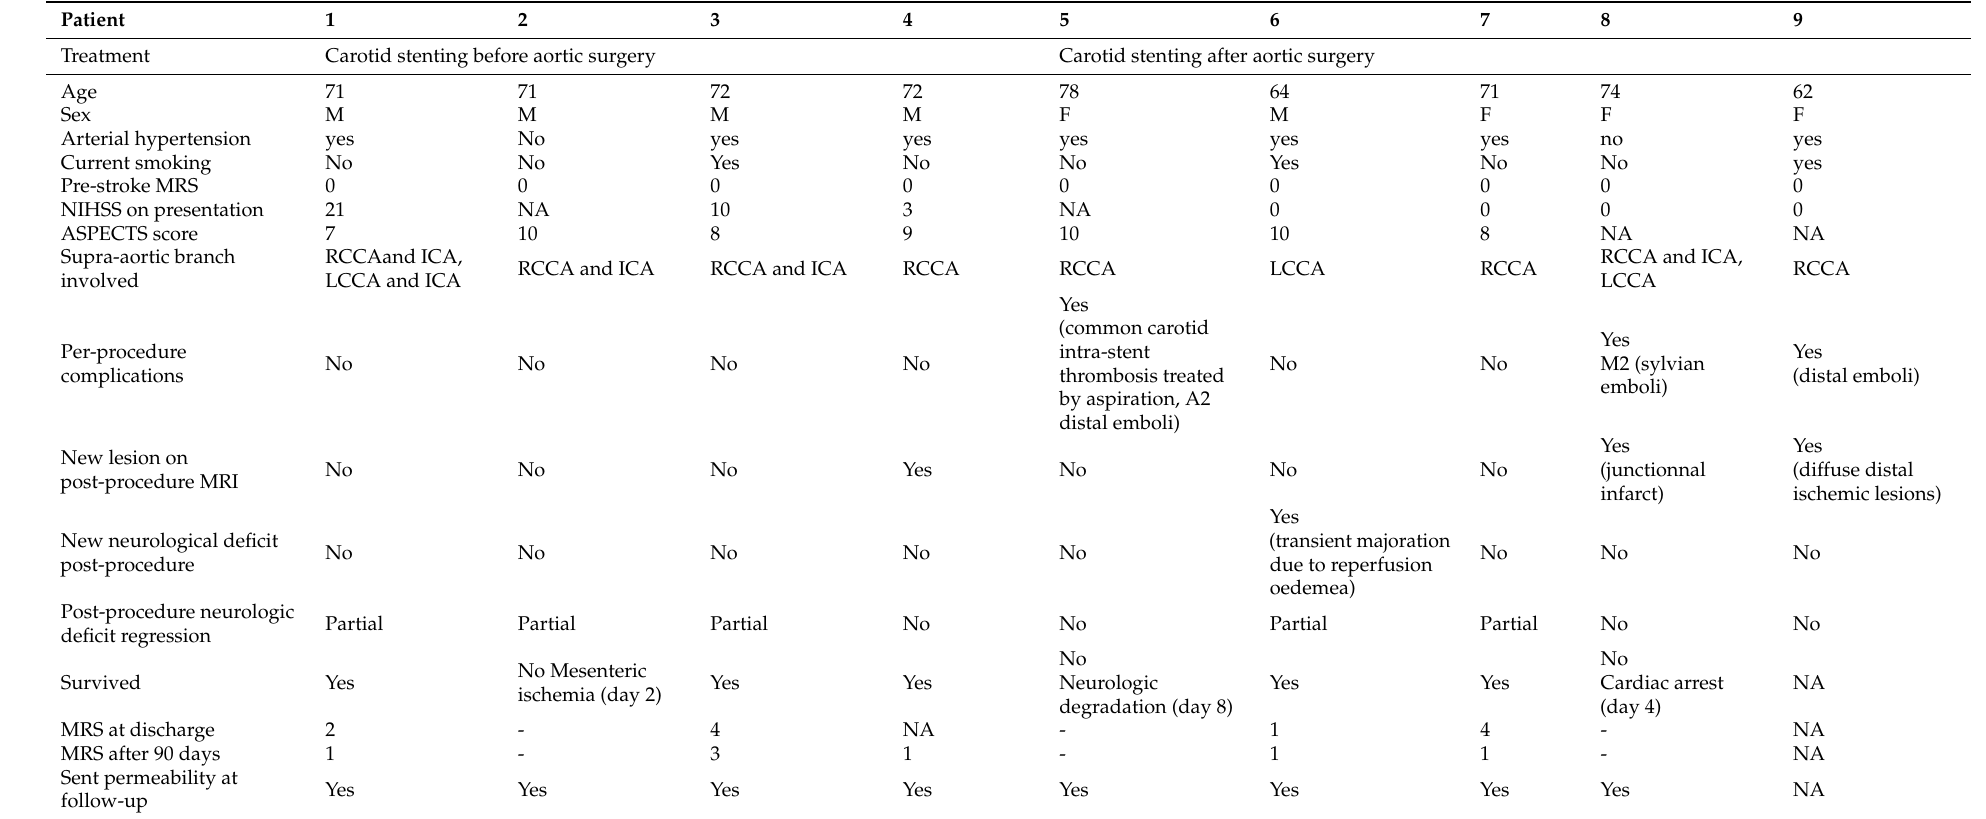
Table 1. Local patients